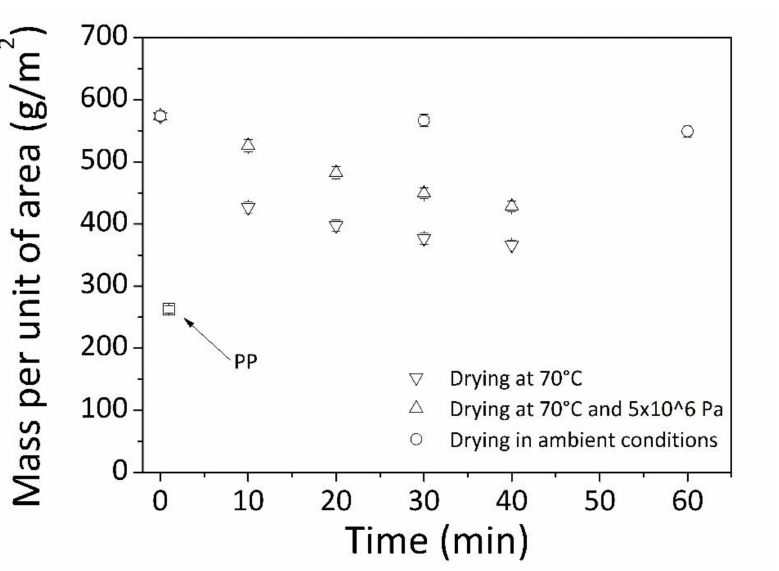
Figure 4. Mass per unit of area of impregnated textiles against time during drying phase. From data, for wetted samples heated at 70 ◦ C (triangles points down), the drying